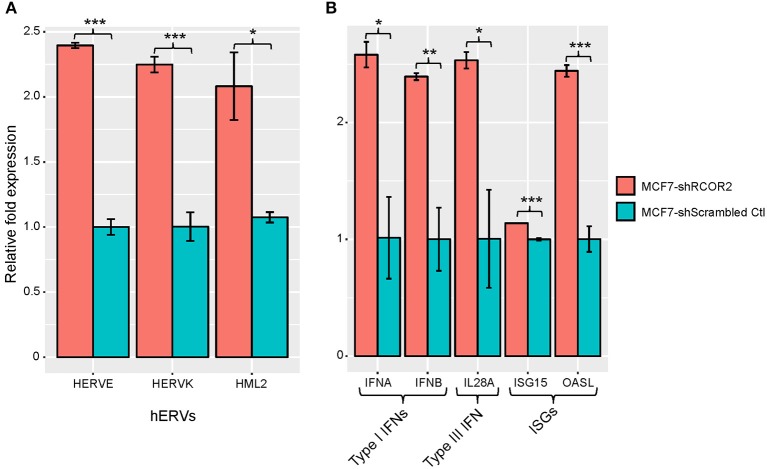
REST corepressor 2 (RCOR2) negatively regulates human endogenous retrovirus (hERV), IFN, and interferon-stimulated gene (ISG) expression. shRNA-mediated downregulation of RCOR2 in MCF7 cells resulted in significantly increased expression of (A) hERVs and (B) type I IFNs, type III IFN, and ISGs. Significance codes: *p < 0.05; **p < 0.01; ***p < 0.001 (Student's t-test). Error bars show the standard error of the mean (n = 3). Refer to Supplementary Table 5 for qPCR primer pairs used in this analysis.